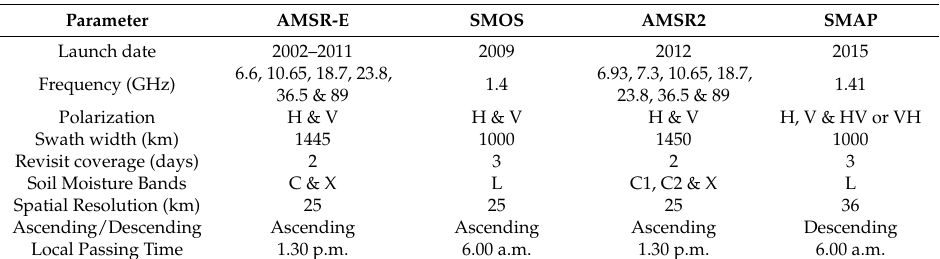
Table 1. Passive microwave sensors used to develop soil moisture data sets from 1978 to 2016 (modified from